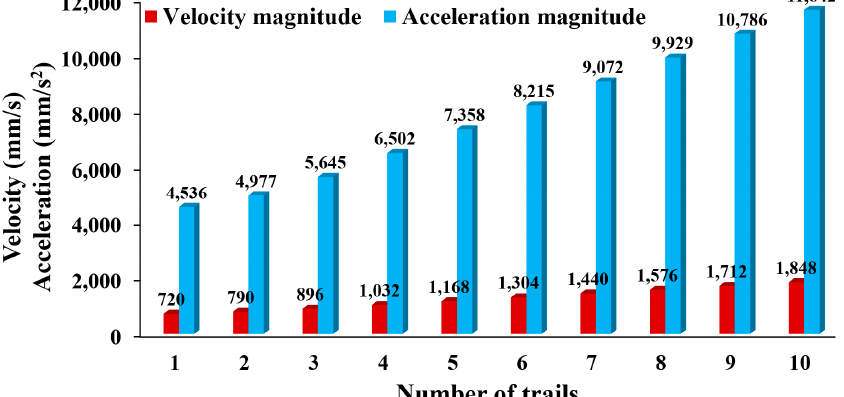
Figure 9. Simulated results for the maximum magnitudes of velocity and acceleration for different trial representing different combinations of the primary and connecting links of the planting mechanism (see details in Table 5).